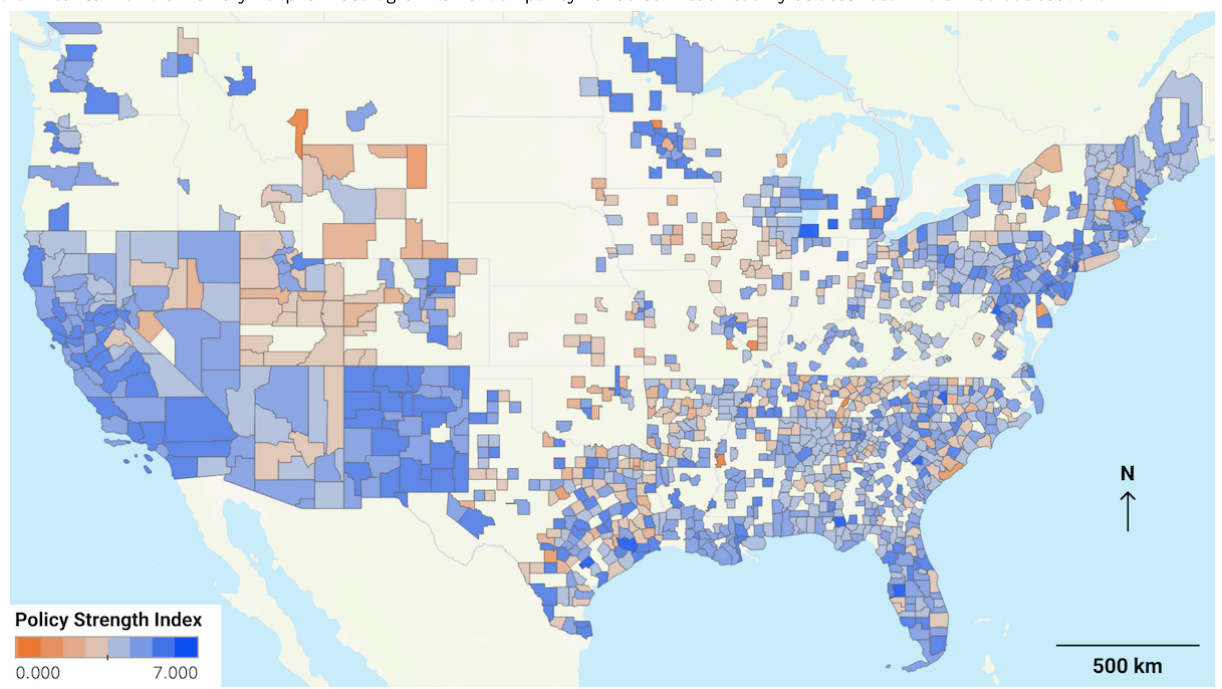
Figure 1. Map showing that county policies are uncorrelated and highly variable between and within states. Policy Strength Index (PSI) for the current policies data set mapped by county indicates that across states, there was wide variability in policy implementation on July 15, 2020. The PSI is calculated as the linear sum of the 7 binary nonpharmacologic intervention policy variables in each county as described in the Methods